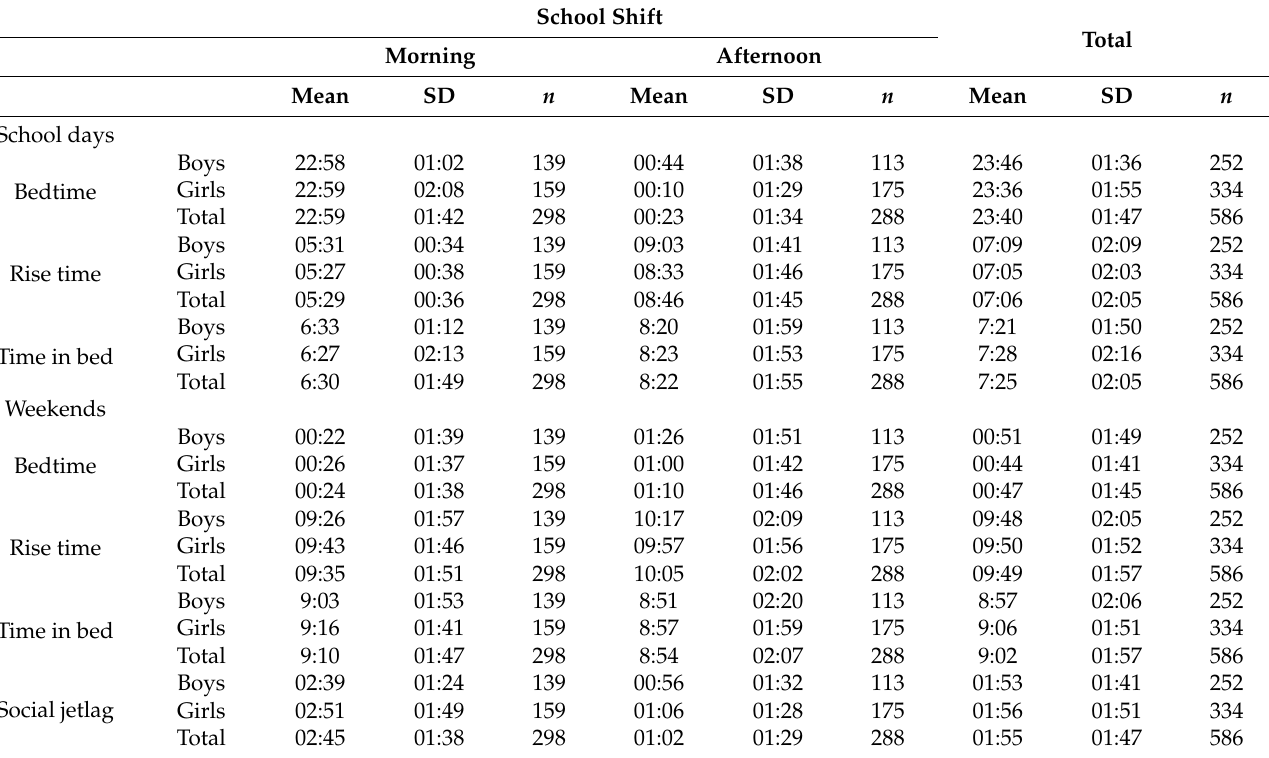
Table 1. Means, standard deviation (SD), and the number of participants according to school shift and sex for sleep habits (hh:mm), and social jet lag.